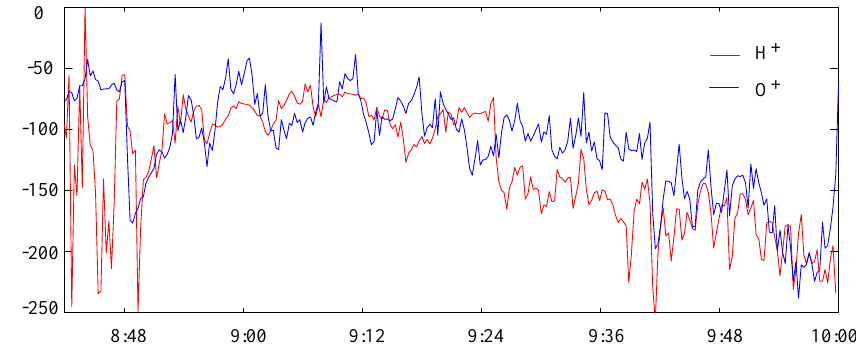
Fig. 5. Parallel velocity for O + (blue) and H + , calculated for upward moving particles only (red). O + (blue spacecraft 3, green spacecraft 4), panel 2 the field- perpendicular velocity of O + (GSE coordinates, blue, green red for x, y, z, respectively), panel 3 the density of H + and O + (same colour code as parallel velocity), panel 4